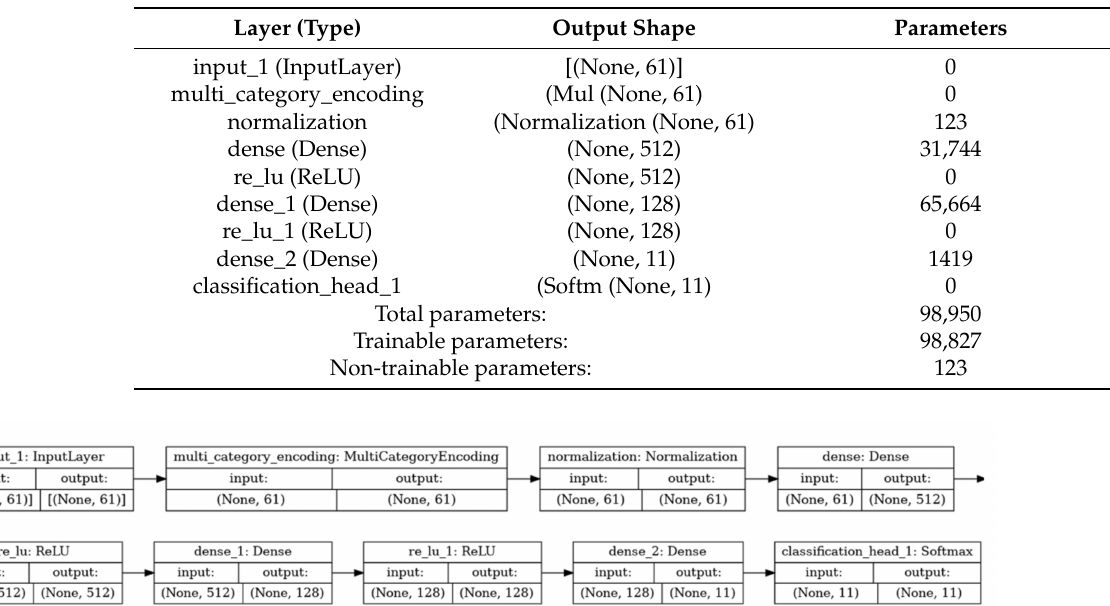
Table 3. AutoKeras model.